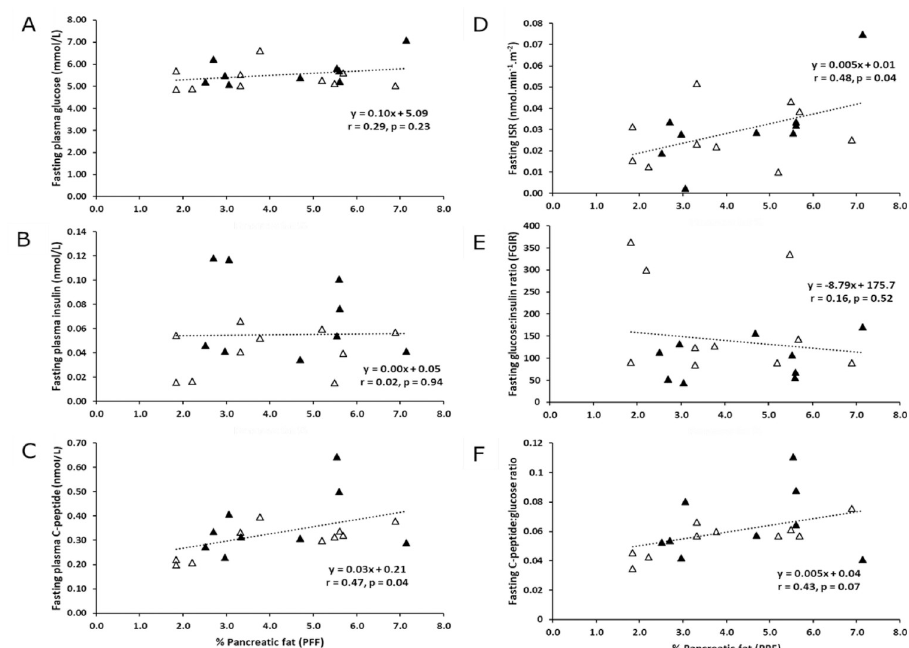
Fig 2. Relationships between baseline circulating plasma glucoregulatory biomarkers, the rate of insulin secretion and indices of insulin sensitivity with MR-determined percentage pancreatic fat in all women (n = 10 Caucasian women open triangles; n = 9 Chinese women solid triangles).